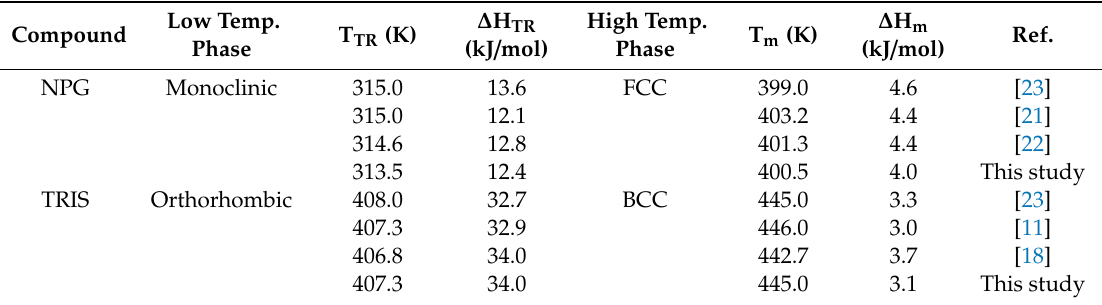
Table 1. Crystal structures, temperature and enthalpy of transition from the low temperature ordered structure to the high temperature ODIC (T TR , ∆ H TR ), and melting point and latent heat of fusion of the ODIC (T m , ∆ H m ) for pure NPG and